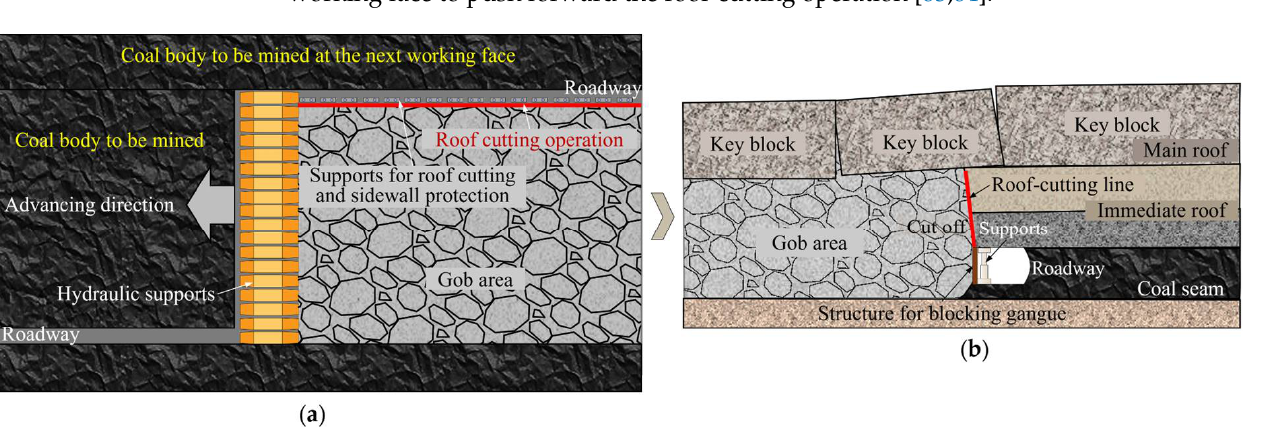
Figure 13. Cutting roof and retaining roadway technology in the “N00” construction method. ( a ) Plane diagram of “N00” construction method ( b ) The diagram of the retained roadway.